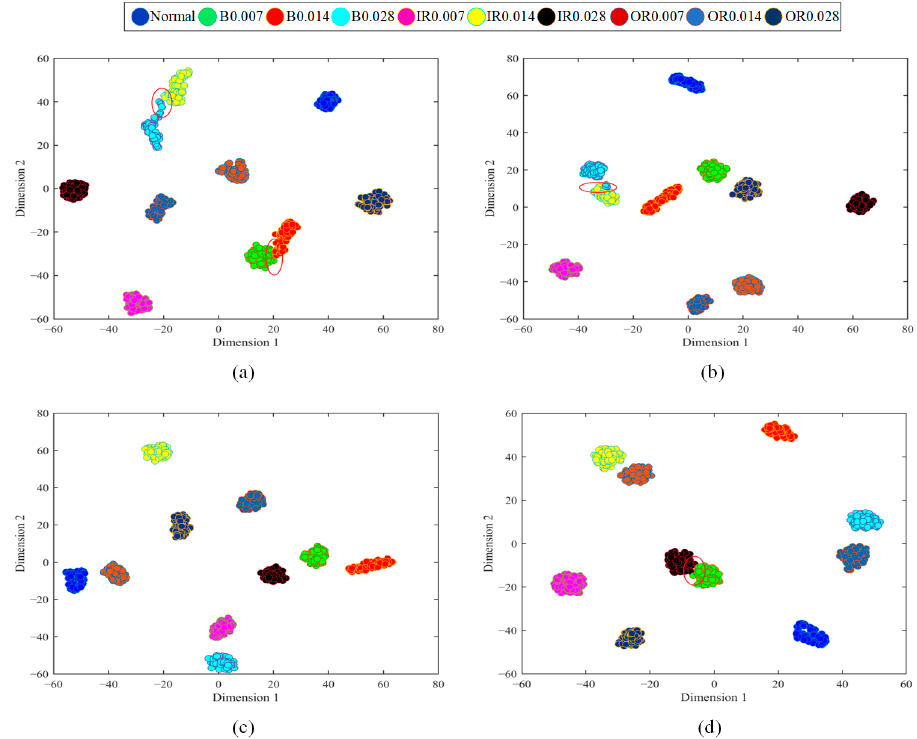
Figure 11. Visualization diagram of 2-D bearing fault features. ( a ) The proposed approach in A. ( b ) SF in A. ( c ) The proposed approach in D. ( d ) SF in